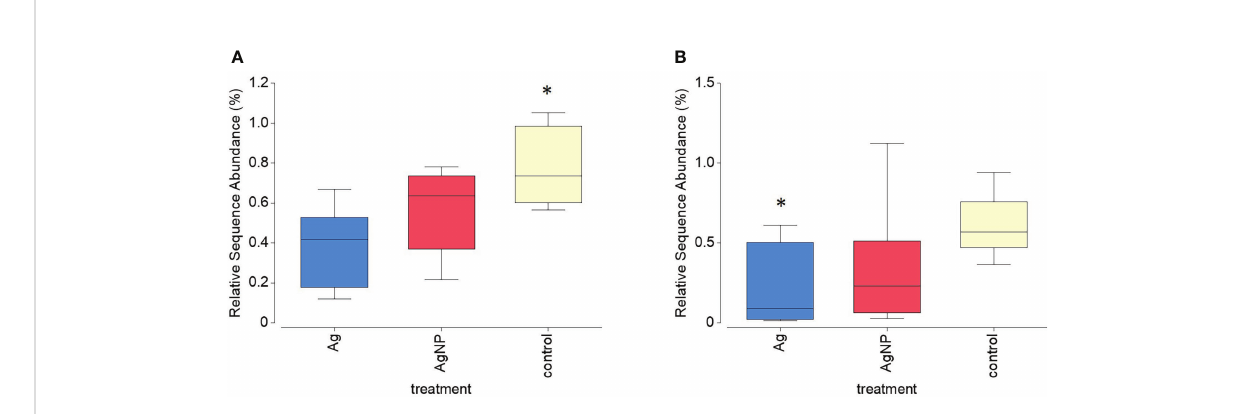
FIGURE 9 Relative sequence abundance of two ASVs (A) Gammaproteobacteria Ectothiorhodospiraceae and (B) Verrucomicrobia Opitutales ) that signi fi cantly declined within treatments containing Ag + and AgNP. Asterisks above boxplots indicate levels of signi fi cance